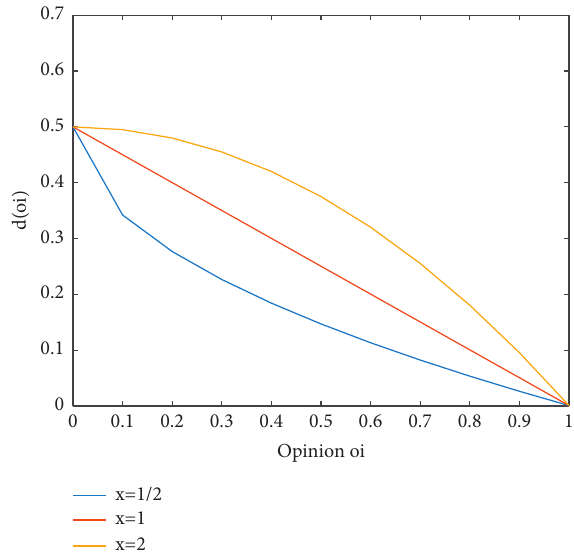
Figure 1: Graph of the function of the tolerance threshold d the opinion value o i , for x � 1/2 , 1 , 2 and d The larger the value of x is, the larger d i is for the same value of o i